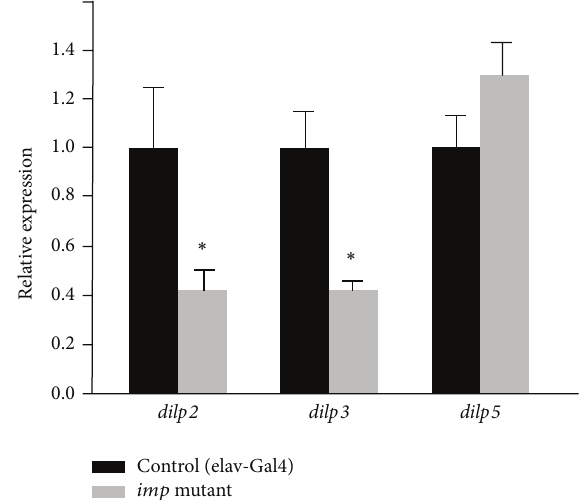
Figure 3: dilp2 and dilp3 expression are significantly reduced in the imp mutant larvae. q-PCR analysis was conducted to examine the dilp expression on the third instar larva in the fed state. dilp2 and dilp3 , but not dilp5 , were reduced to less than the half of the control strain. ∗ 𝑃 < 0.05